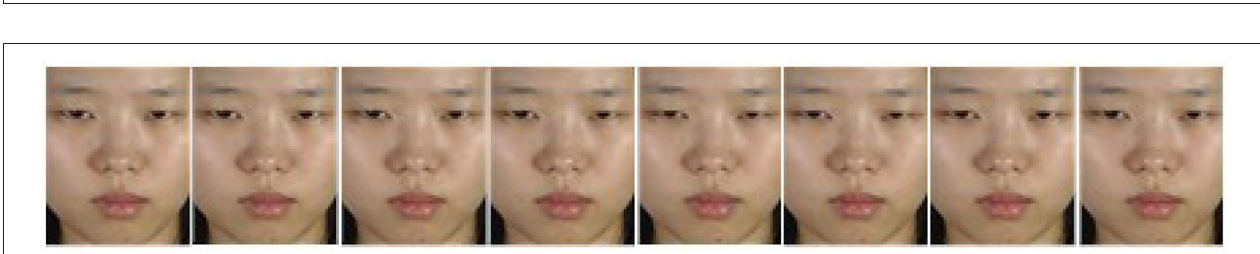
FIGURE 2 | Sample frames from a “Happiness” sequence (Subject 6) in CASME II. Images reproduced from the database with permission from Yan et al. (2014a).